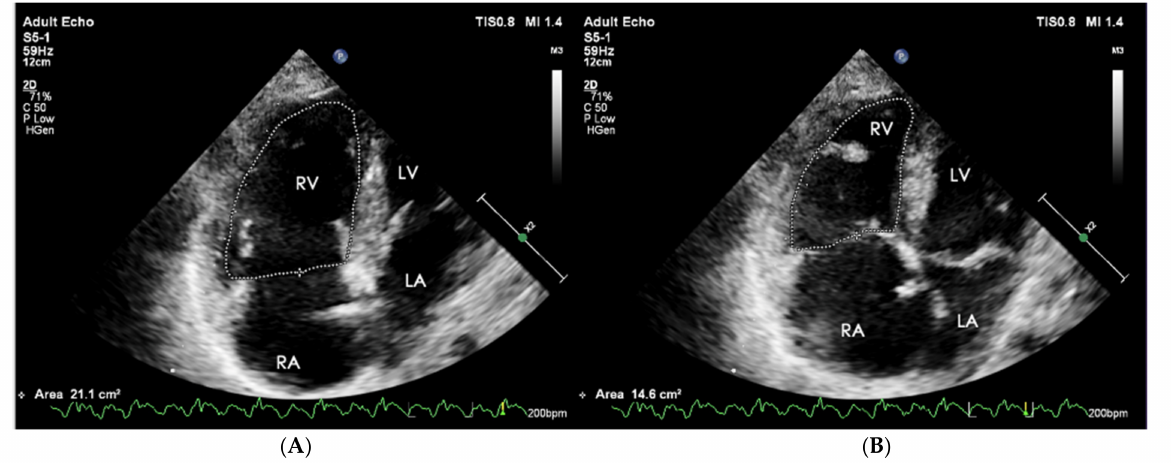
Figure 9. ( A ) End-diastolic volume RV = 21.1 cm 2 , ( B ) end-systolic volume RV = 14.6 cm 2 . FAC = 30.8%. FAC = A(diast) − A(sys)/A(dias) * 100%. 2D-TTE, 4CH view. RV: right ventricle; FAC: functional area change; 2D-TTE: two-dimensional transthoracic echocardiography; 4CH: